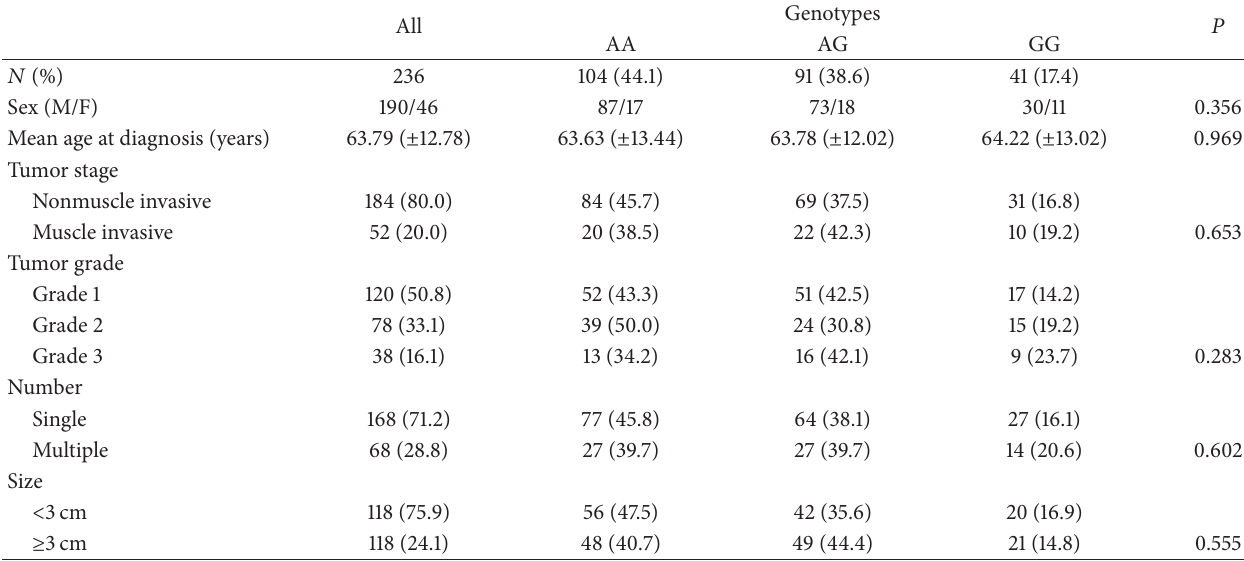
Table 8: Genotype and allele frequencies of the TSP-1 -1223 A/G polymorphism among the bladder cancer cases with survival information. Recurrence ( 𝑛 = 78 ) Genotypes